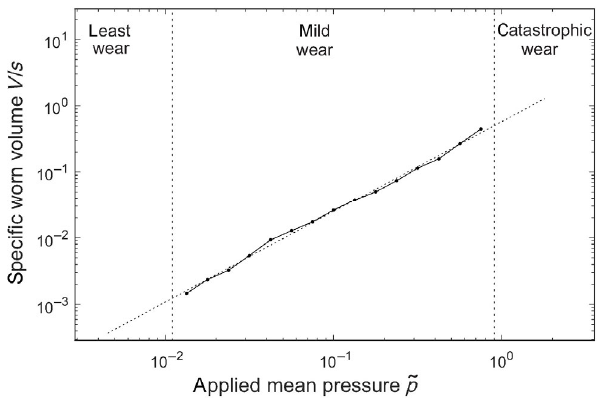
Fig. 13 Dependency of the wear volume per distance as a function of the applied external load for a constant flow stress 10   . Other Parameters as in Fig. 4. For very low loads, no 0 wear occurs in the model (least wear mode). At very high loads, very large particles emerge which the model cannot